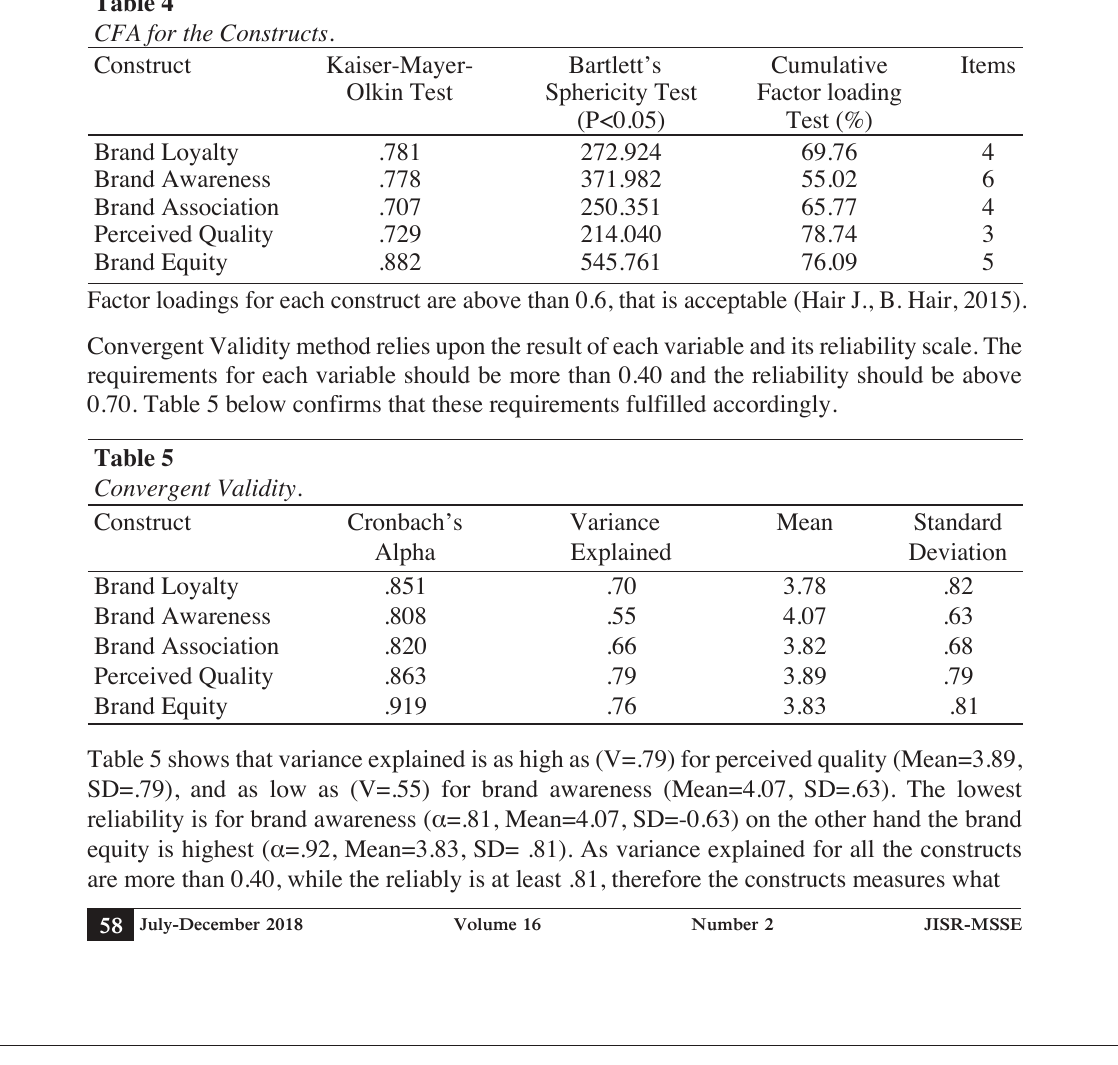
CFA for the Constructs.